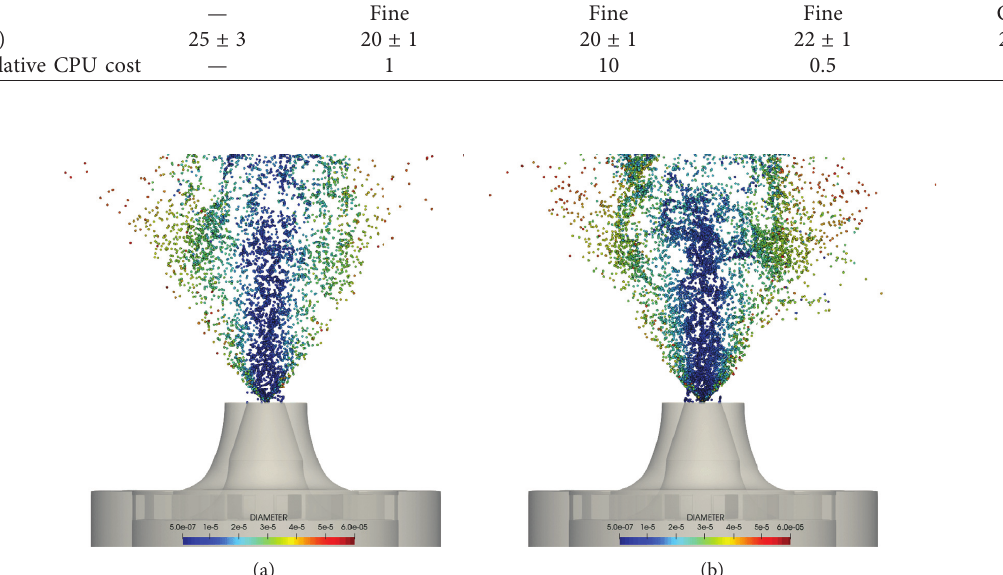
Figure 19: Droplet diameter for cases A-NR (a) and B-NR (b).